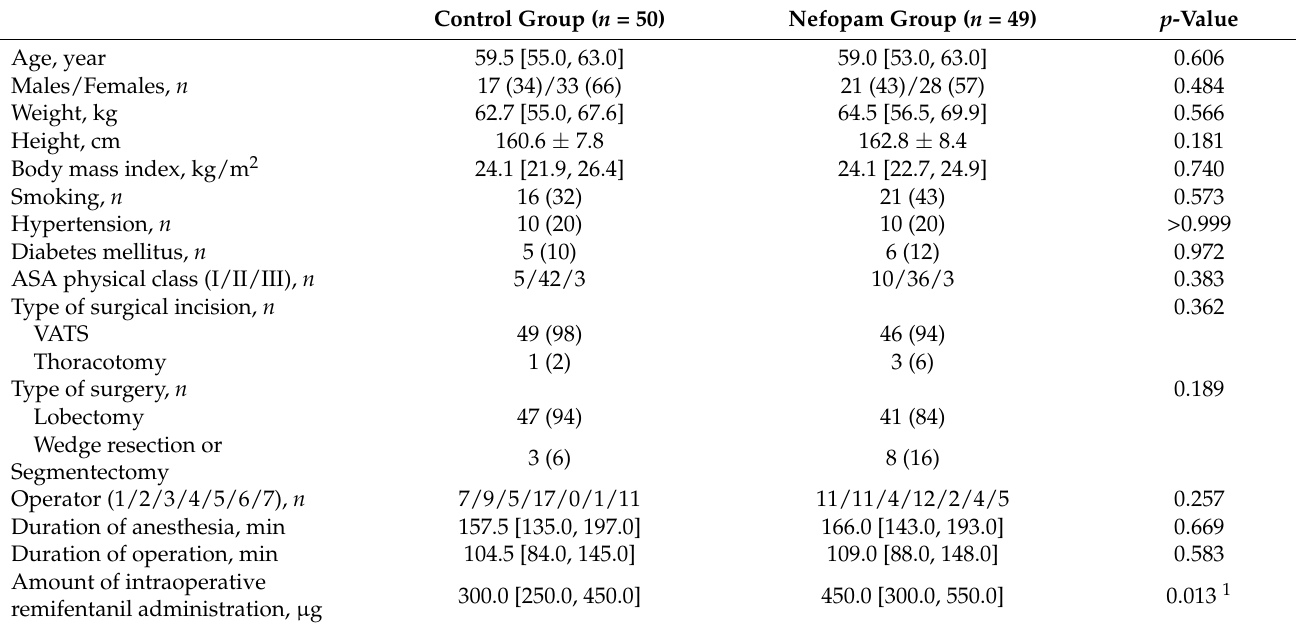
Table 1. The baseline characteristics and perioperative clinical data.